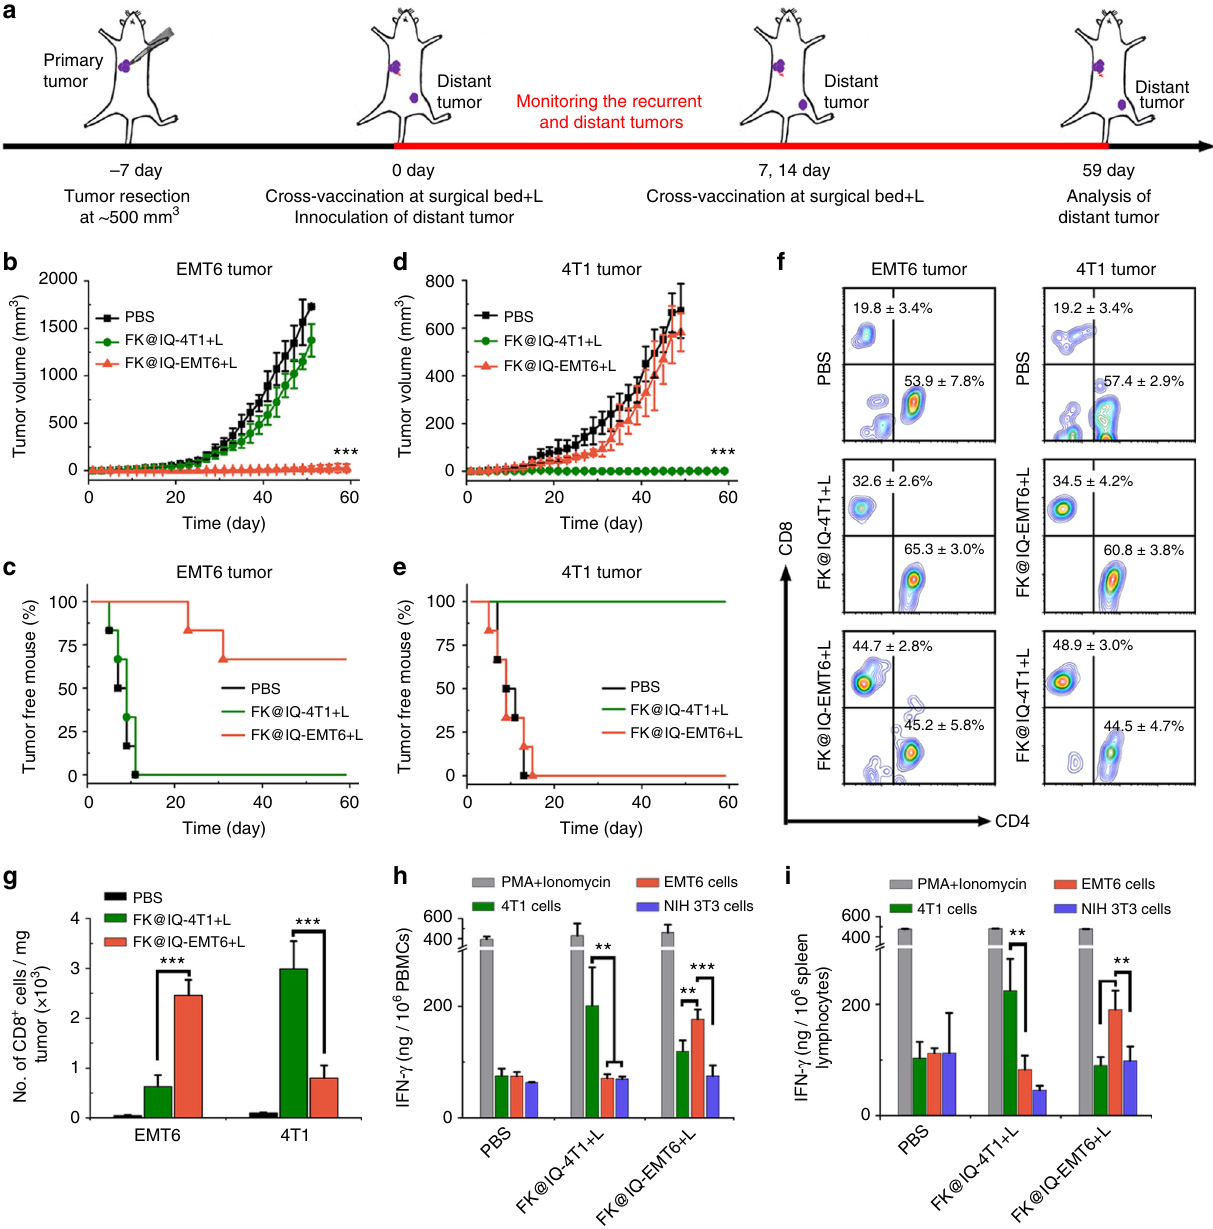
Fig. 6 Cross-vaccination of 4T1 and EMT6 tumor xenografts by autologous or allogeneic cancer vaccines. a Cross-vaccination experimental design. b , c Distant tumor growth curves and tumor-free percentages of the distant EMT6 tumor-bearing BALB/c mice model. The mean tumor volumes were analysed using one-way ANOVA. *** p < 0.01. Data represent mean ± s.d. ( n = 6). d , e Distant tumor growth curves and tumor-free percentages of the distant 4T1 tumor-bearing BALB/c mice. The mean tumor volumes were analysed using one-way ANOVA. *** p < 0.01. Data represent mean ± s.d. ( n = 6). f Representative fl ow cytometry plots showing the proportions of tumor-in fi ltrating CTLs in distant EMT6 or 4T1 tumors. Data represent mean ± s.d. ( n = 3). g Tumor mass-normalized intratumoral in fi ltration of CD8 + T cells in distant EMT6 or 4T1 tumors. h , i Vaccination-induced secretion of tumor speci fi c IFN- γ by the h peripheral blood mononuclear lymphocytes (PMBCs), and i the spleen lymphocytes, respectively. g – i Unpaired student ’ s t -test (two-tailed) was used for the comparison between two groups. *** p < 0.01. Data represent mean ± s.d. ( n = evidence for JQ1-mediated blockade of the PD-1/PD-L1 check- orthotopic 4T1 tumor models were established by s.c. implana- point in vivo. tion of the 4T1 tumor cells into the right mammary fat pad of BALB/c mice. The majority of the primary tumor was surgically resected when the tumor volume reached 500 mm 3 . The surgical bed was then vaccinated with PBS, FK-IQ, FK@IQ-4T1 or PVAX inhibits the postoperation tumor recurrence and FK@ICG-4T1 at an identical ICG dose of 2.5 mg/kg and JQ1 dose metastasis . The high ef fi cacy of FK@IQ-4T1 + L to promote DC of 3.4 mg/kg when the recurrent tumors reached 100 mm 3 . Two maturation in vitro and in vivo prompted us to address whether hours post vaccination, the surgical bed of the FK-IQ, FK@ICG- the FK@IQ-4T1 vaccine induced antitumor immune response 4T1 and FK@IQ-4T1 groups was illuminated with an 808 nm can prevent postsurgical tumor recurrence and metastasis. The